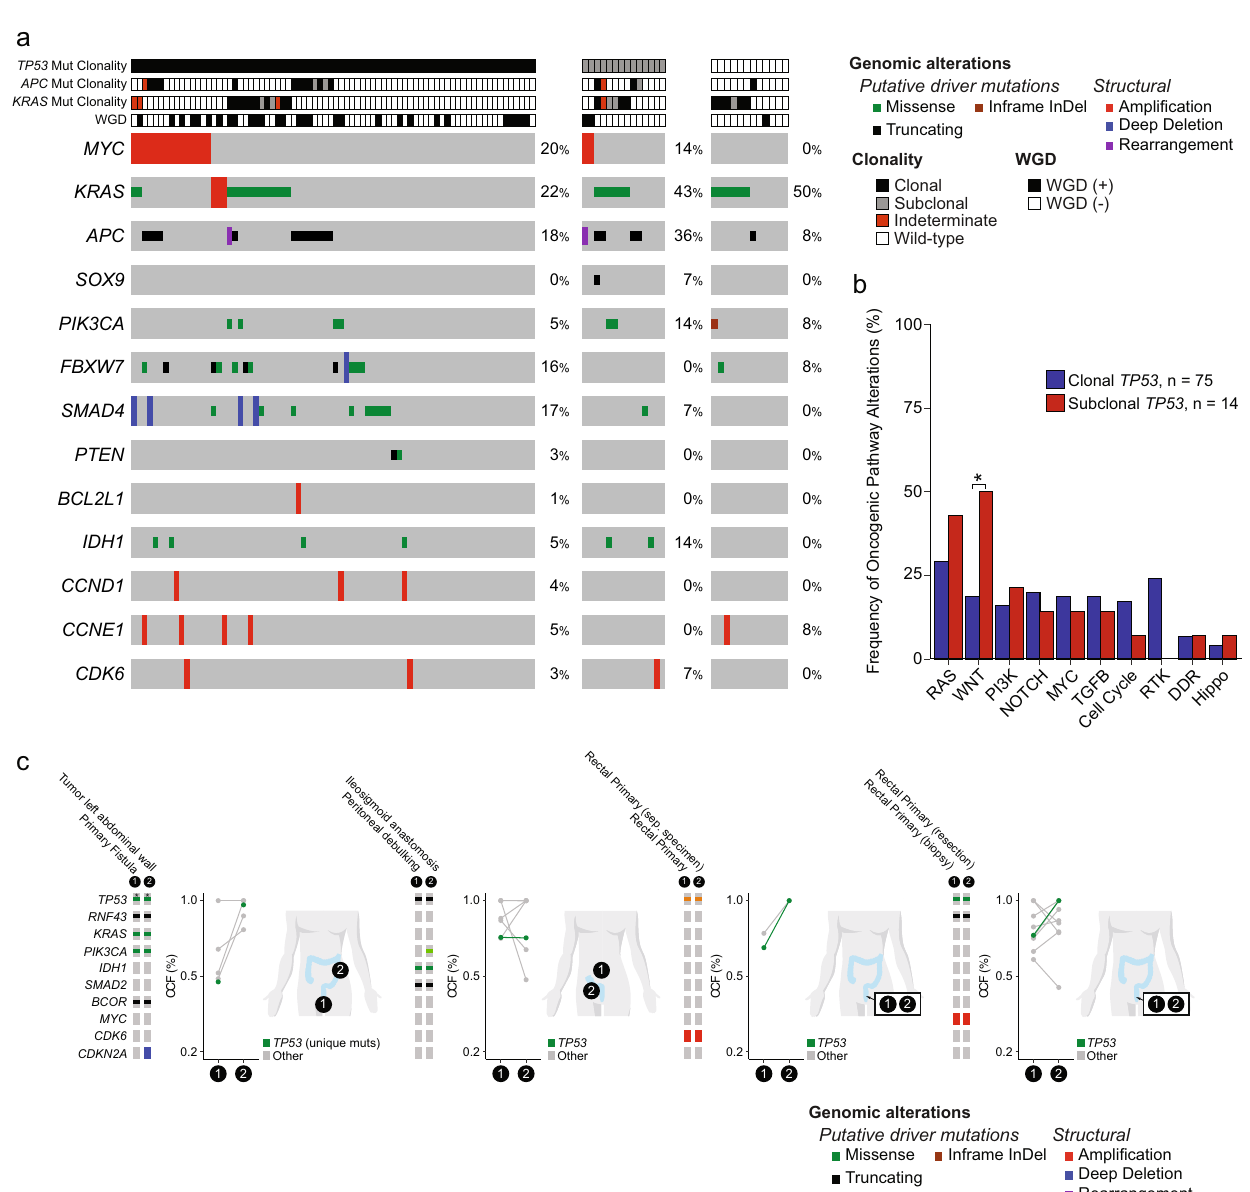
( P =0.017). c Sites ofmultiple samples, genomic alterations, and changes in cancer cell fractions (CCF) of shared mutations from CAC specimens sequenced from patients with CAC with subclonal TP53 alterations. Source data are provided as a Source Data fi